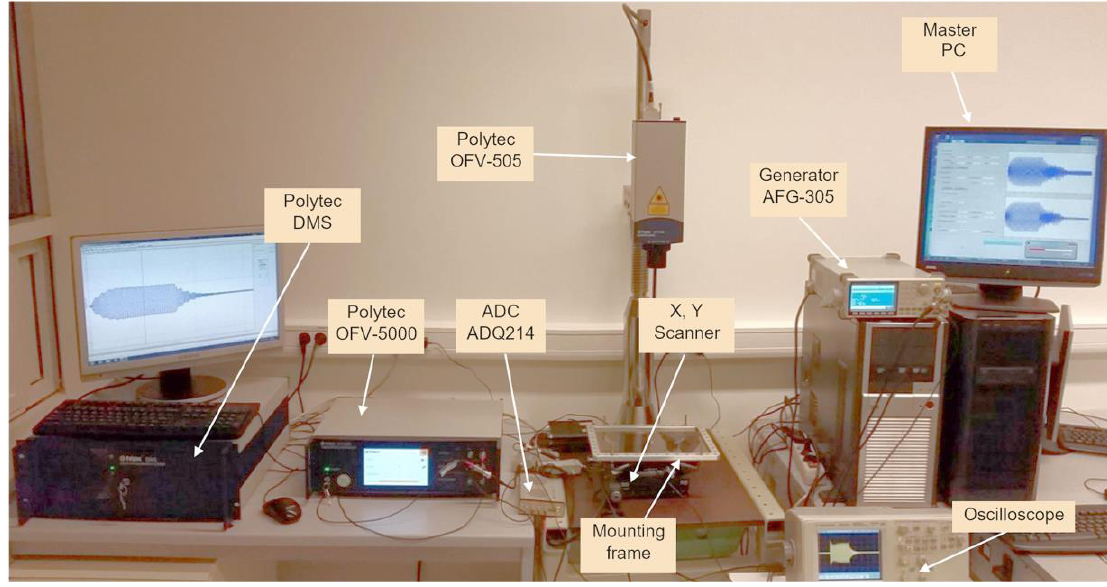
Figure 9. The overall view of experimental set-up.